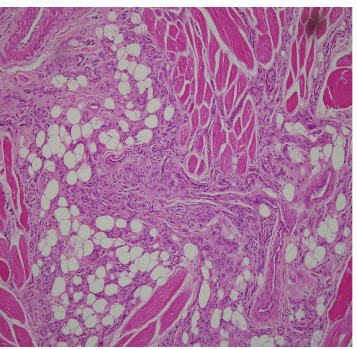
Figure 2: Striated muscle fibres separated by a network of predomi- nantlythinwalledcapillarieswithnarrowluminaandscatteredthick walled veins admixed with irregular lobules of adipocytes in a thin fibrocollagenous stroma are seen. Only occasional cavernous vessels are present. (H&E ×